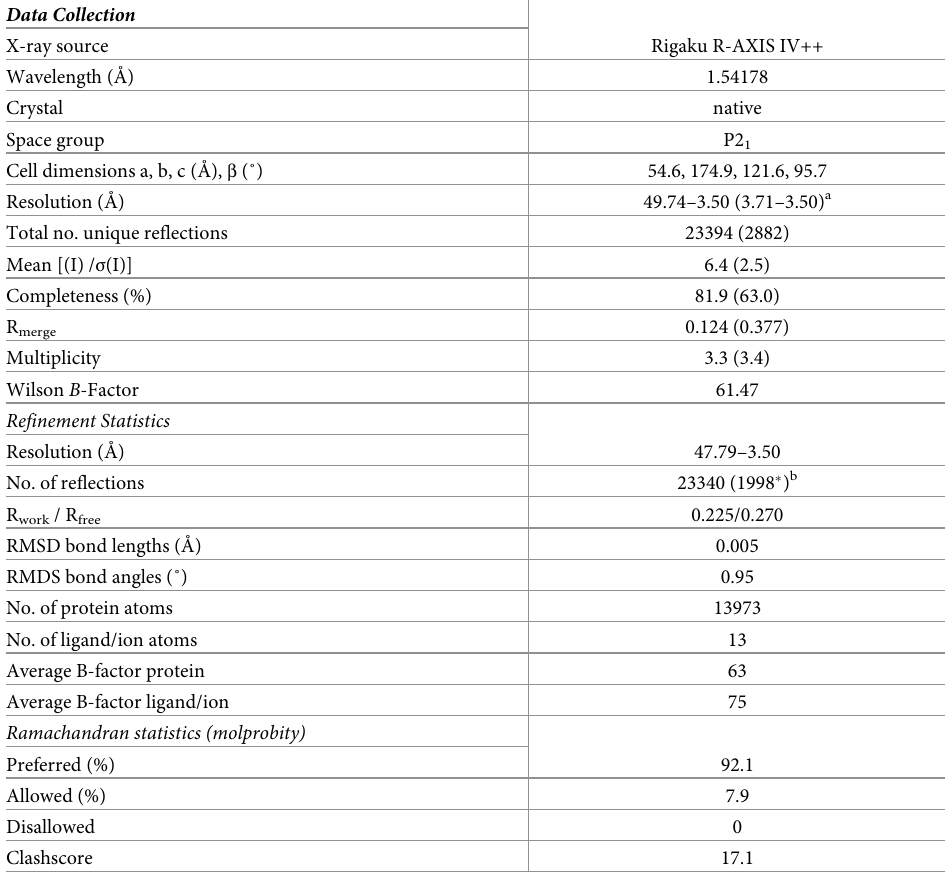
Table 1. Data Collection and Refinement Statistics for the X-ray Structure of the SARS-CoV-2 PLpro/UbV.CV2.1